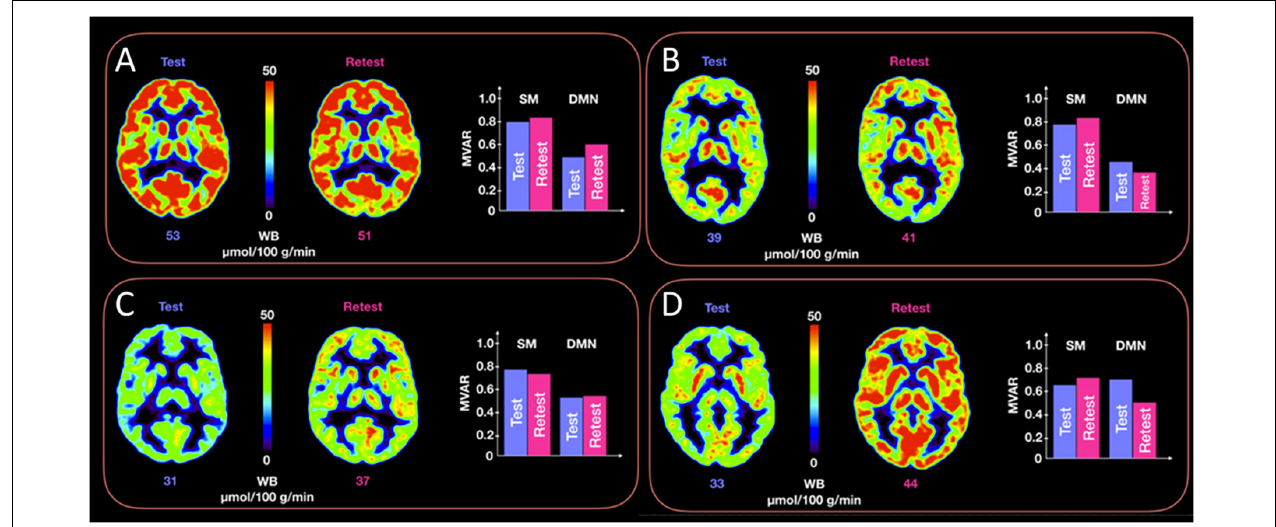
FIGURE 5 | Representative CMRGlc images with low (top row, panels A,B ) and high (bottom row, panels C,D ) test-retest variability. Each of the four panels (A–D) corresponds to a different subject at rest and retest condition. Each panel renders a trans-axial cross-section through the subject’s brain at the level of the caudate head obtained at rest and retest condition, together with bar graphs representing test-retest changes in MVAR coefficients for the DMN and Sensory-motor (SM) networks. The figure demonstrates a similar distribution of MVAR coefficient changes for subjects with low (top row) and high (bottom row) CMRGlc variability across time. WB, whole brain